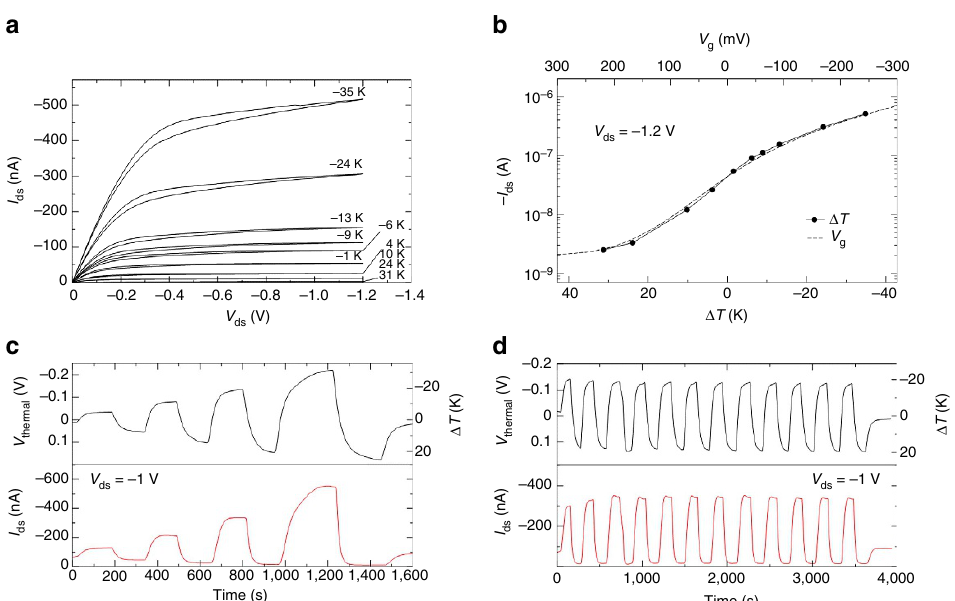
Figure 3 | Electrical characteristics of the heat-gated transistors. Output characteristics at different fixed gating D T (Ti gate, channel length L ¼ 2 m m) ( a ). Transfer characteristics with channel length ¼ 2 m m ( b ). Output current tracking with the variation of D T ( c ). Multi circles operation of the heat-gated transistor ( d